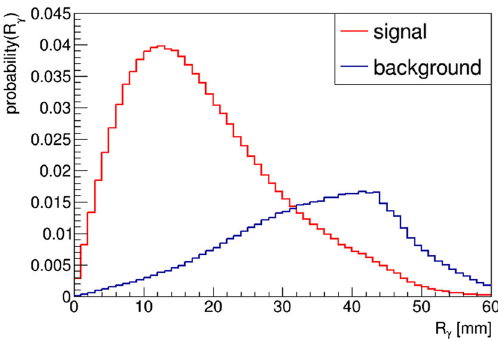
Fig. 6 The distribution of the distance, R γ , between the reconstructed photon impact point at the ZDC and the beam projection (areawise normalised). The red line the signal event sample, the blue line the background